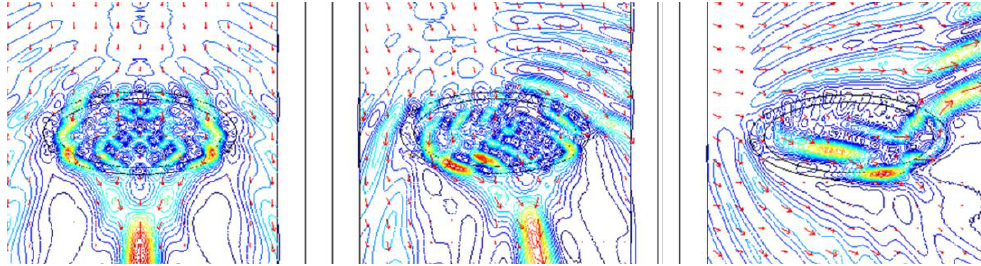
Figure 6. Simulated scatter response for a 300 nanometer mica flake coated with titanium dioxide, being impinged on by 590 nm incident radiation at 0° ( left ), 20° ( center ) and 70° ( right ) angles of